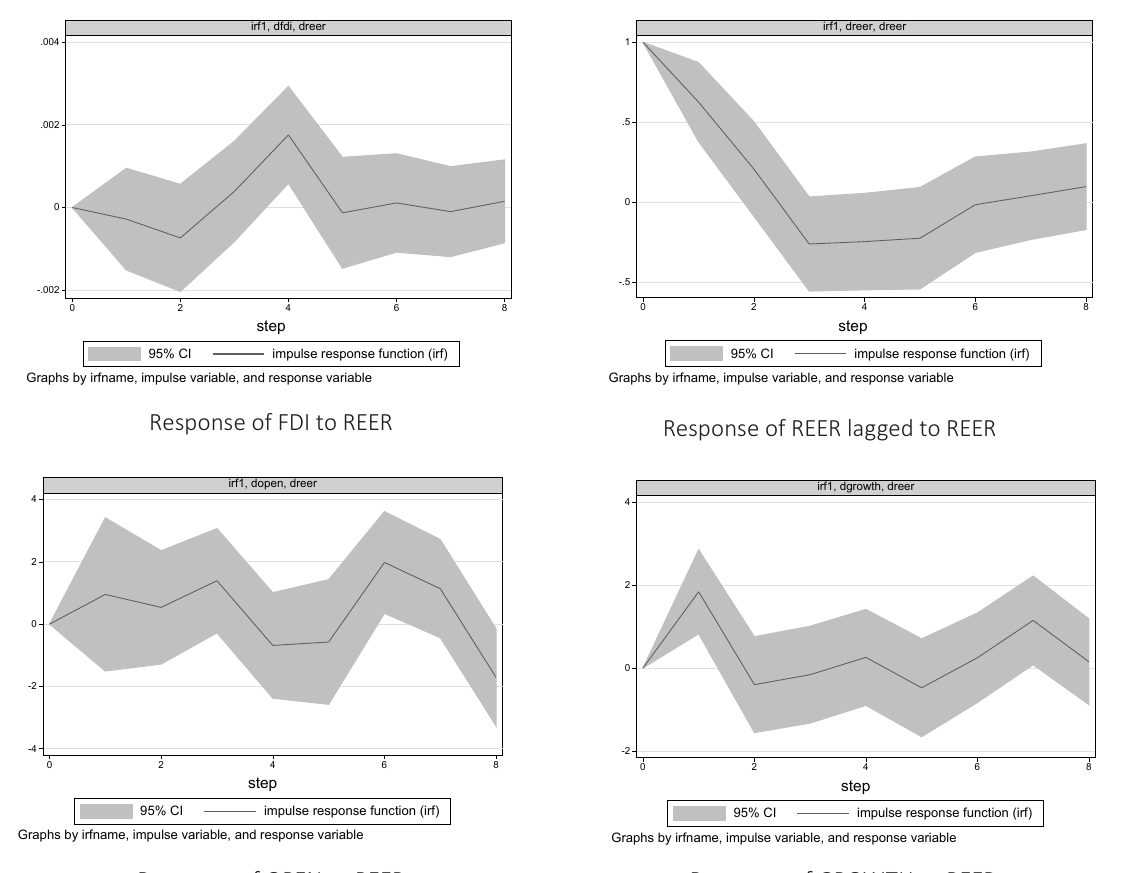
Figure 2. The response of variables to the current REER